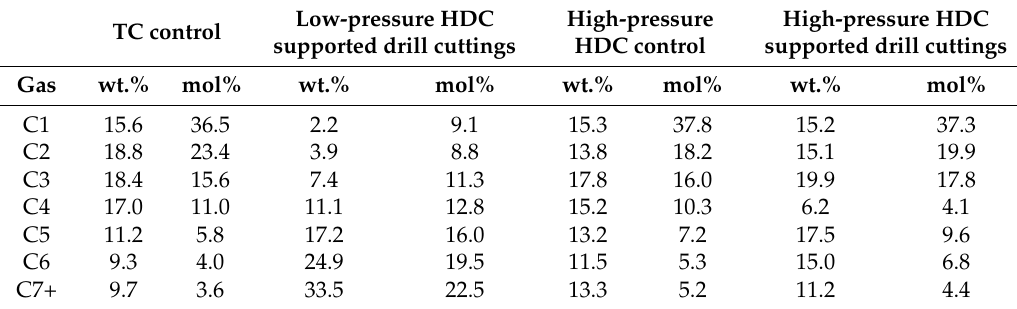
Figure 6. Buildup of pressure for TC and HDC runs. The time at which the temperature inside the reactor reached 300 ◦ C is denoted by t i . The final pressure in the reactor at ambient conditions is denoted by the point at t f . Control (square), raw drill cuttings (triangle), supported drill cuttings (circle). Table 3. Gaseous product analysis for various upgrading